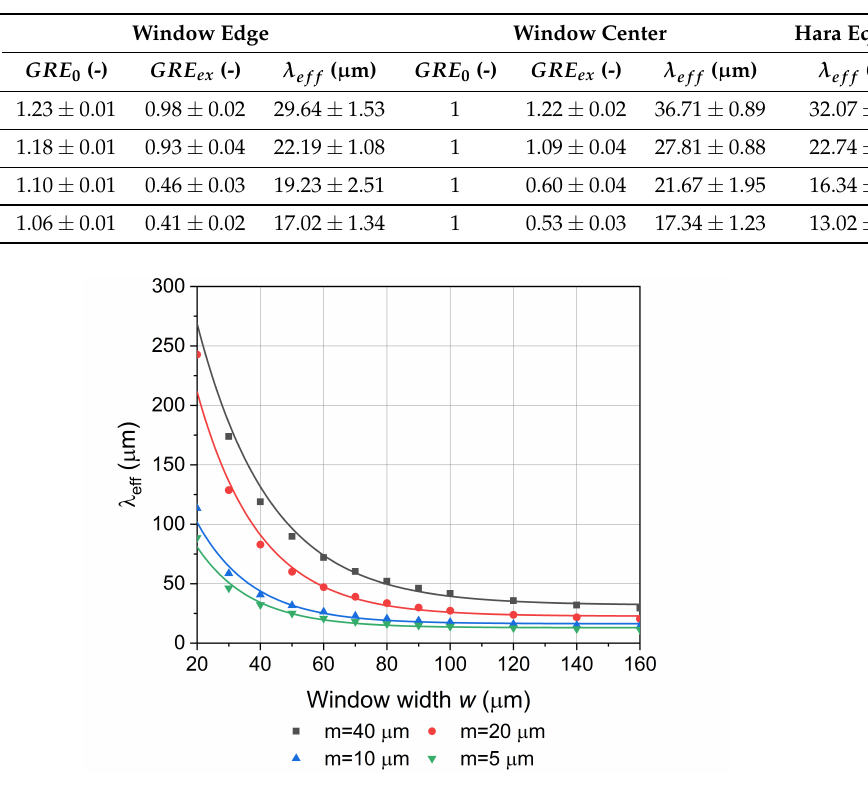
Figure 11. Theoretical effective diffusion length as a function of window width, for different mask widths λ ef f = f ( w ) (Hara Equation